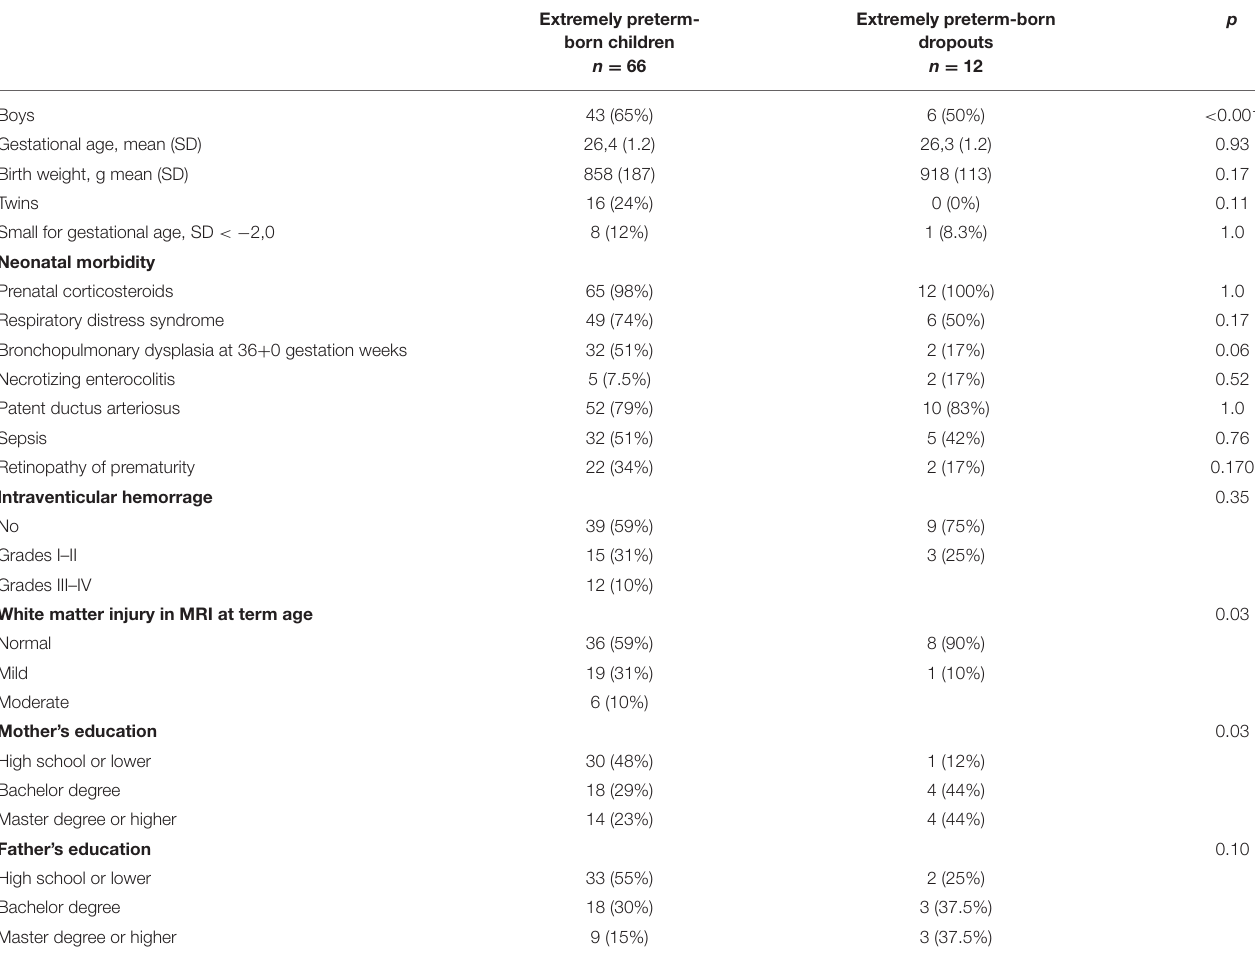
TABLE 1 | Characteristics of the study population.